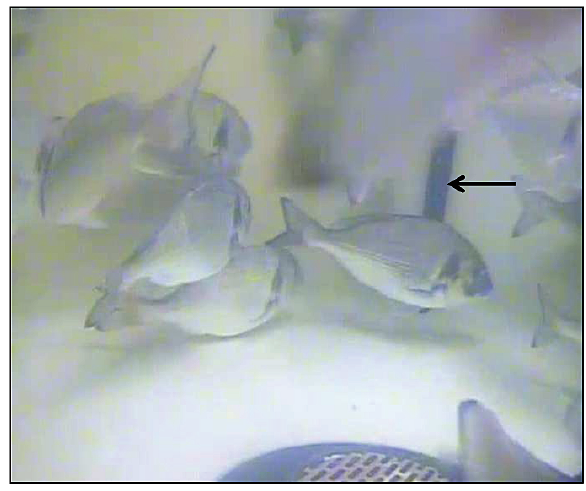
Fig. 1. Measurements of gilthead sea bream Sparus aurata swimming speed during declining O 2 were performed by analysing videos from cameras submerged in the tanks. The time it took for a fish to pass (snout to tail fin) the right side of the inlet pipe (arrow) was noted and swimming speed was recalculated to body lengths per